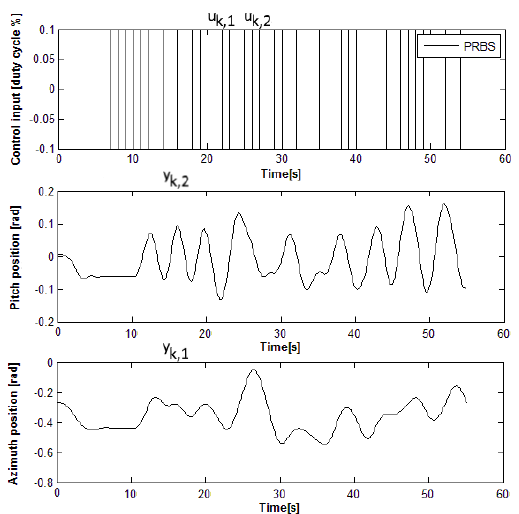
Figure 4. Open-loop input–output (IO) data from the two-inputs–two-outputs aerodynamic system (TITOAS) for Virtual Reference Feedback Tuning (VRFT) controller tuning